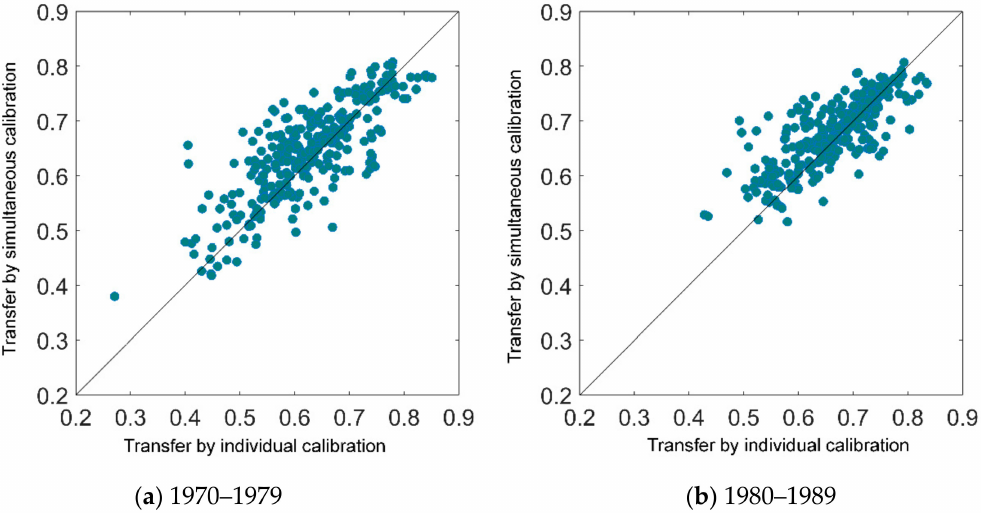
Figure 9. Comparison of model performances for parameter transfer from individual calibration and simultaneous calibration for periods ( a ) 1970–1979 and ( b )